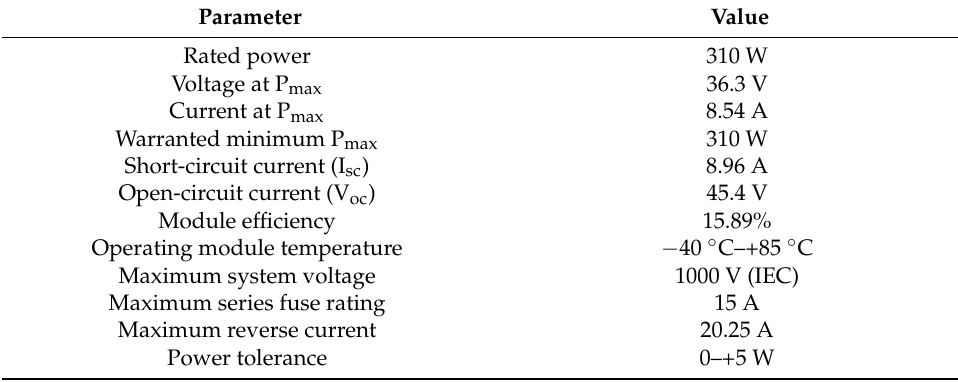
Table 4. Electrical characteristics of the PV module.